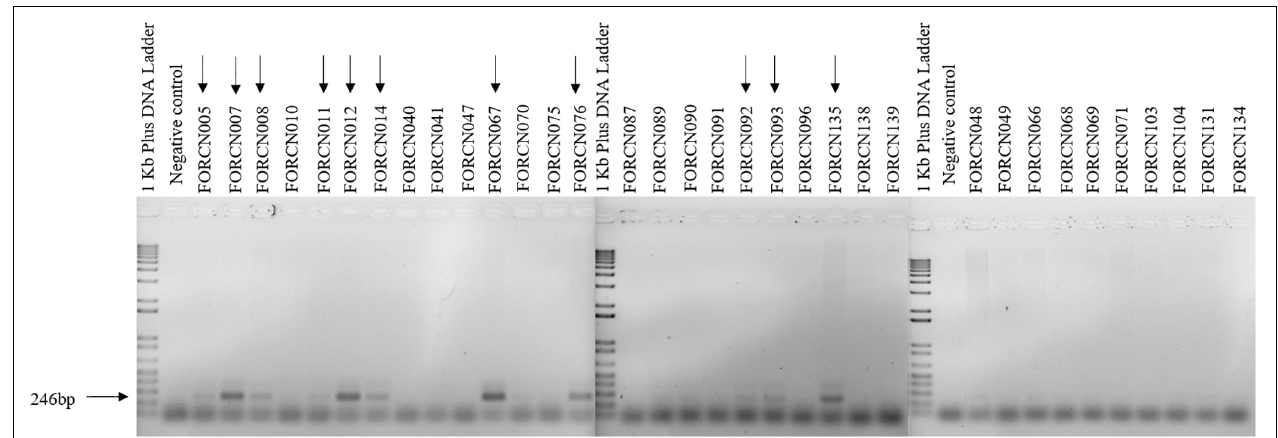
FIGURE 6 | Agarose gels (1.5%) showing the 246 bp PCR amplification product amplified using the specific primers for the XRE transcriptional regulator. The arrows indicate the strains with a positive